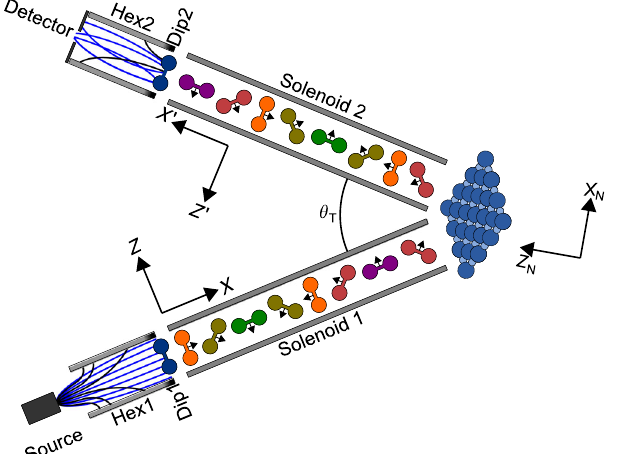
Fig. 1 A schematic of the coherent magnetic manipulation approach 24 . Schematic of the experimental apparatus showing the position and function of the main magnetic elements as well as the different axis de fi nitions mentioned in the text. The two hexapole fi elds (Hex1 and Hex2) are characterised by strong magnetic fi eld gradients, leading to trajectory bending which either focuses (blue) or defocuses (black) the molecules depending on their m I , m J state with respect to the dipole fi elds (Dip1 and Dip2). The hexapole fi elds are used for polarising and analysing the incoming and outgoing molecules respectively. In between these regions, the wave functions evolve coherently, allowing us to control and encode the rotational projection states by altering the magnetic fi elds before and after scattering. This is illustrated graphically in the fi gure as a change of the rotational plane of the propagating molecules, with the different coloured molecules representing different rotational projection states. The angle between the two arms is denoted θ T